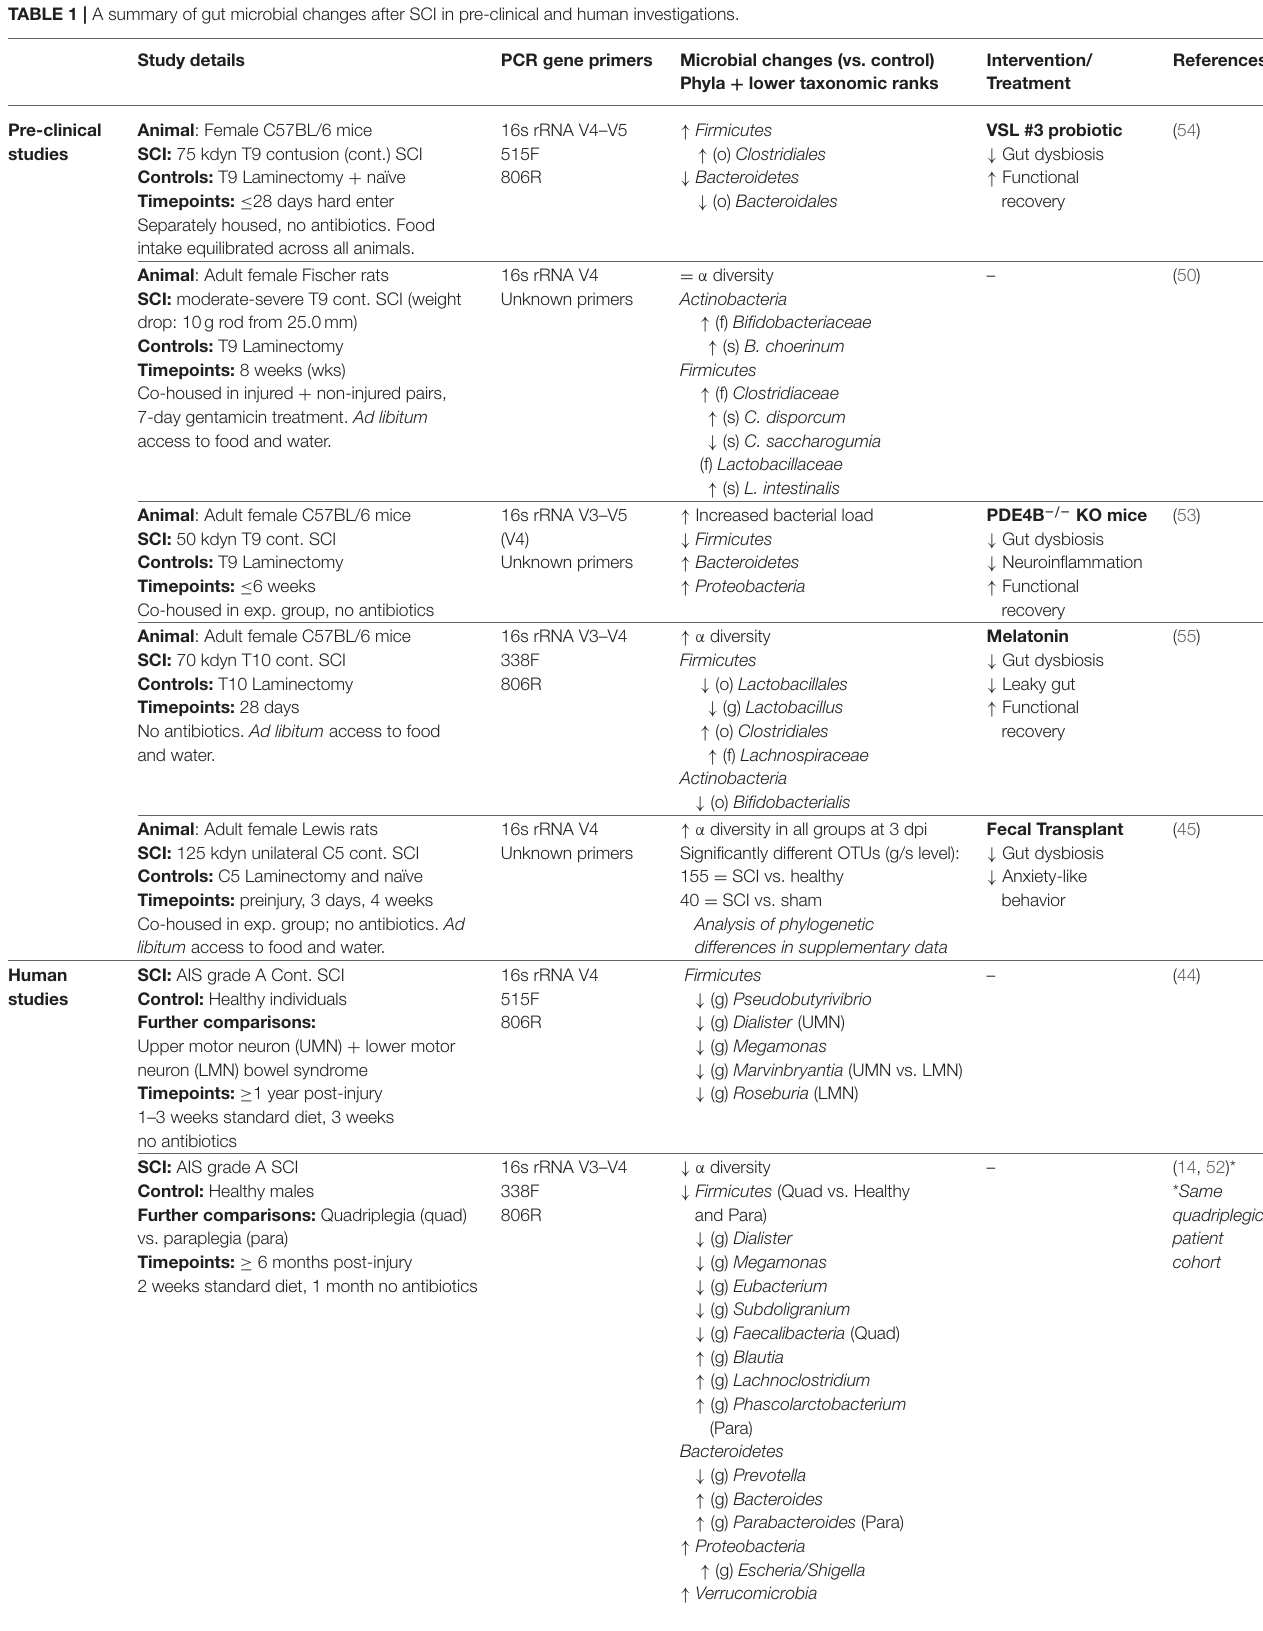
TABLE 1 | A summary of gut microbial changes after SCI in pre-clinical and human investigations. Study